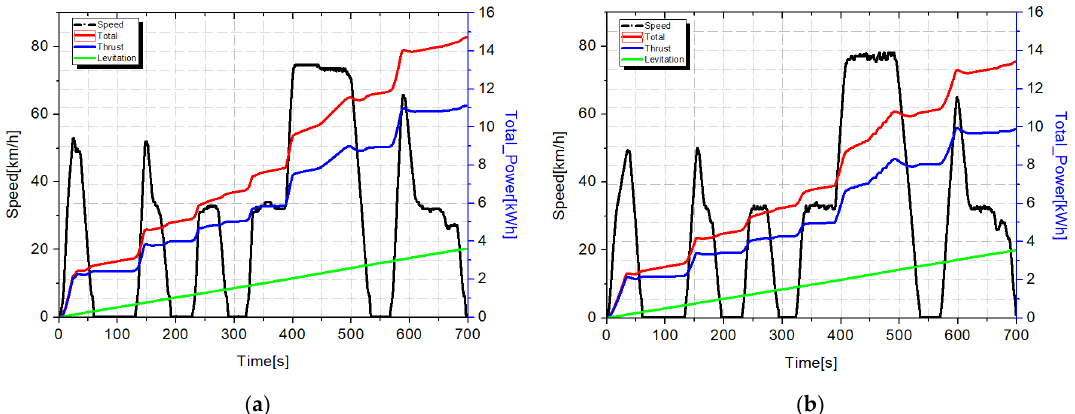
Figure 9. Comparison of accumulated power consumption between existing and proposed methods (101 → 106): ( a ) Conventional method and ( b ) Proposed method